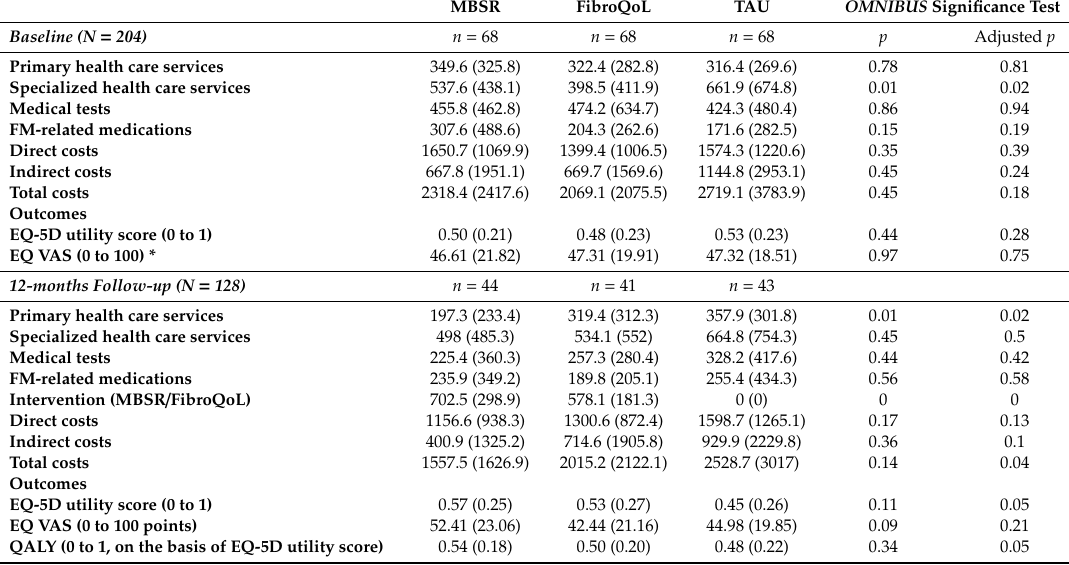
Table 3. Summary statistics of the costs (total and disaggregated in components) and outcomes according to treatment